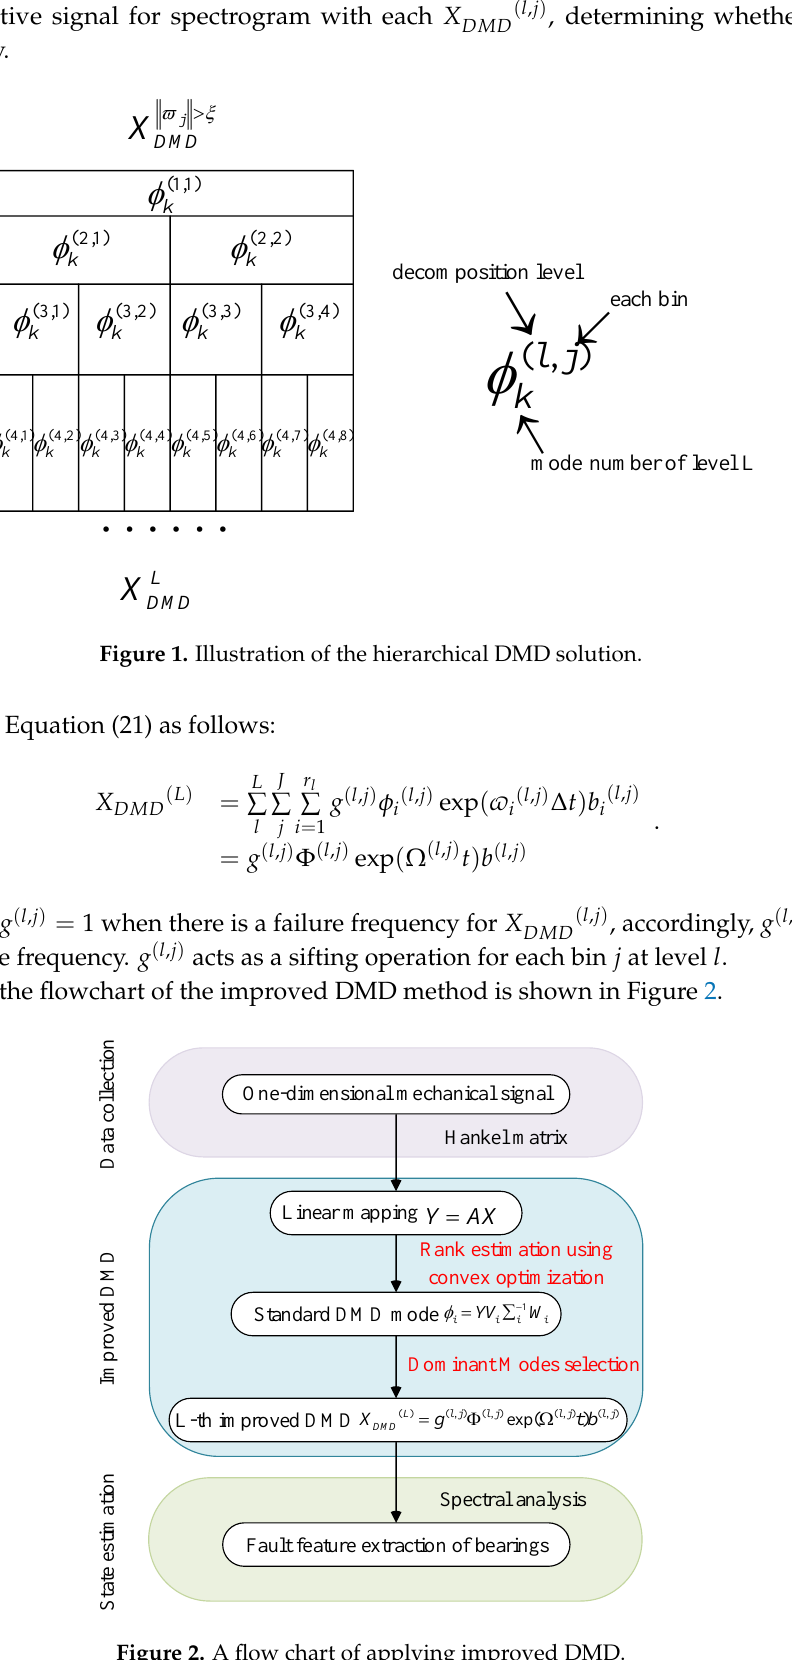
Figure 2. A flow chart of applying improved DMD.